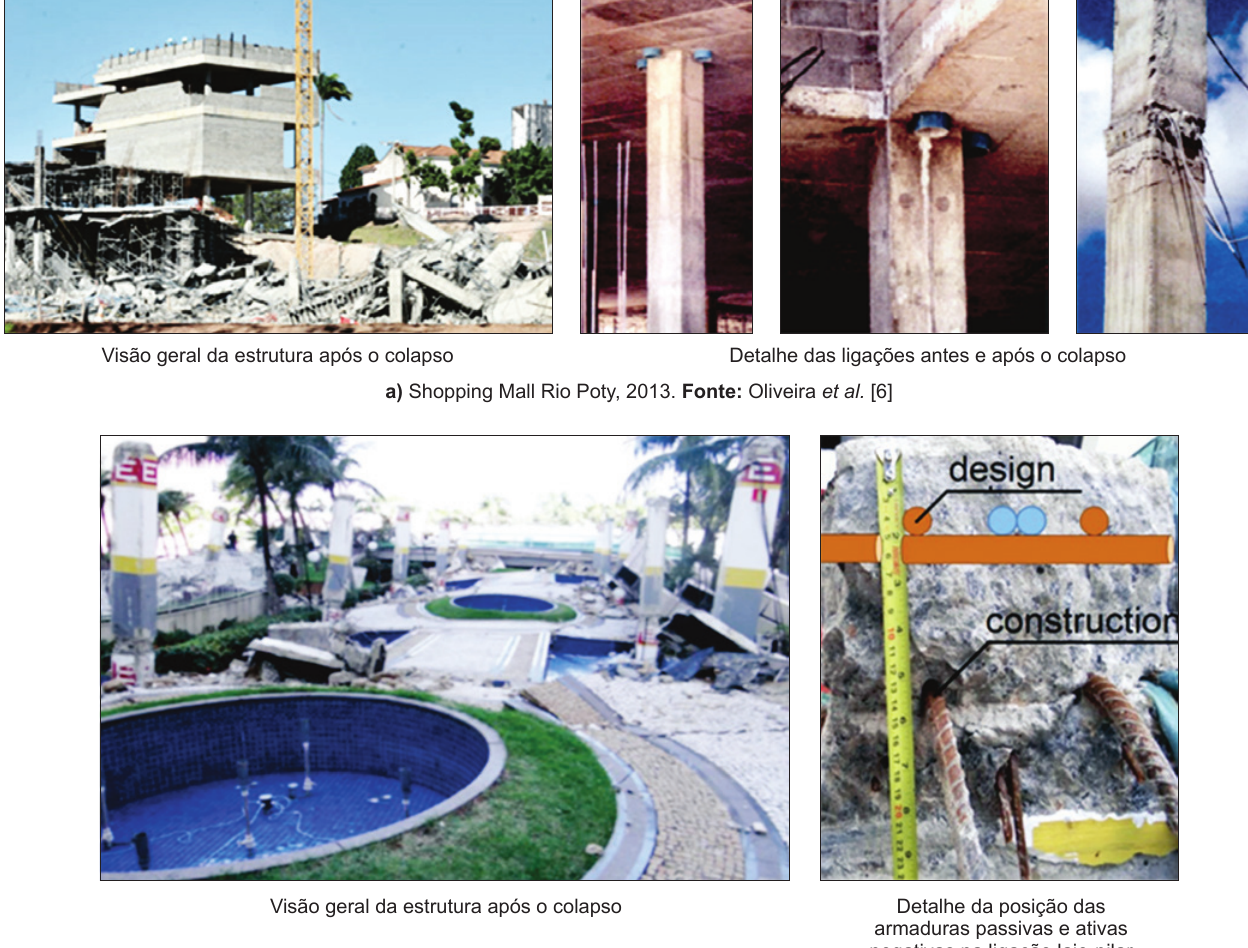
armaduras passivas e ativas negativas na ligação laje-pilar